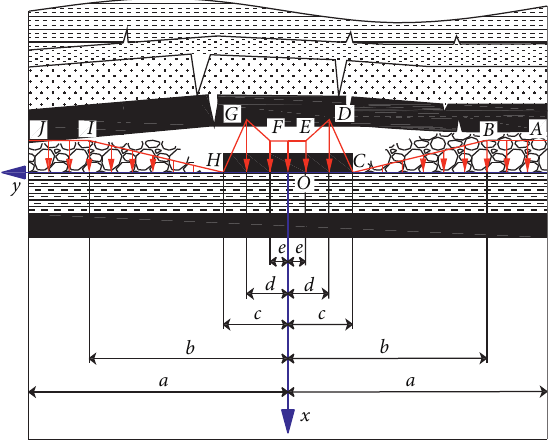
Figure 2: The mechanical model of close-distance coal